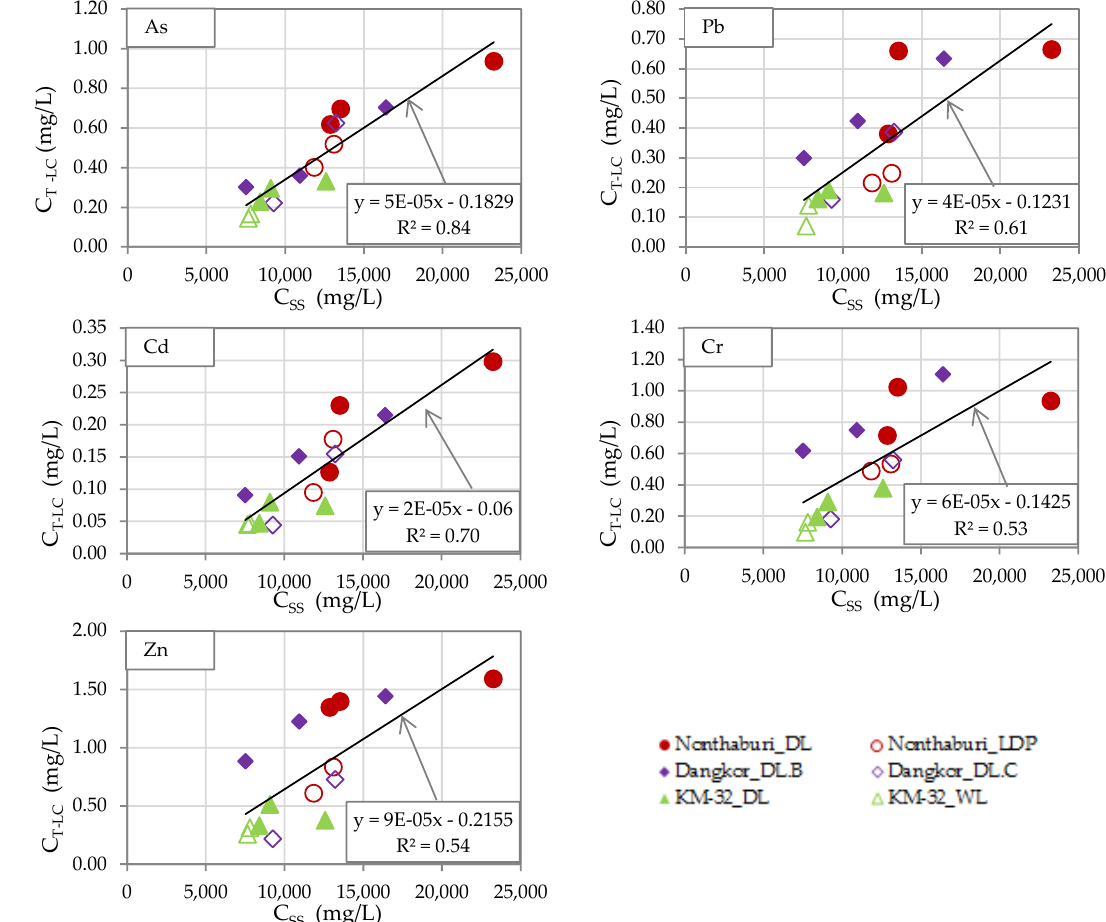
Figure 9. Relationship of total heavy metal concentration of the leachate (C T-LC ) and the suspended solid concentration (C SS ).